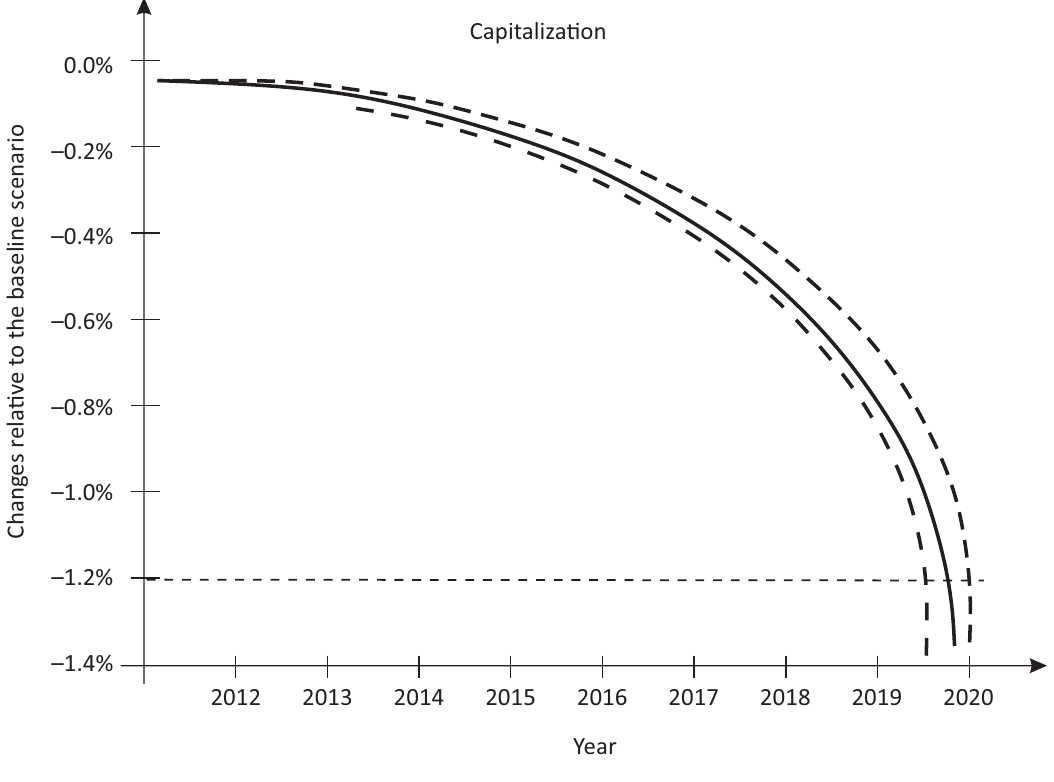
Figure 3. The impact of capitalization on the value of